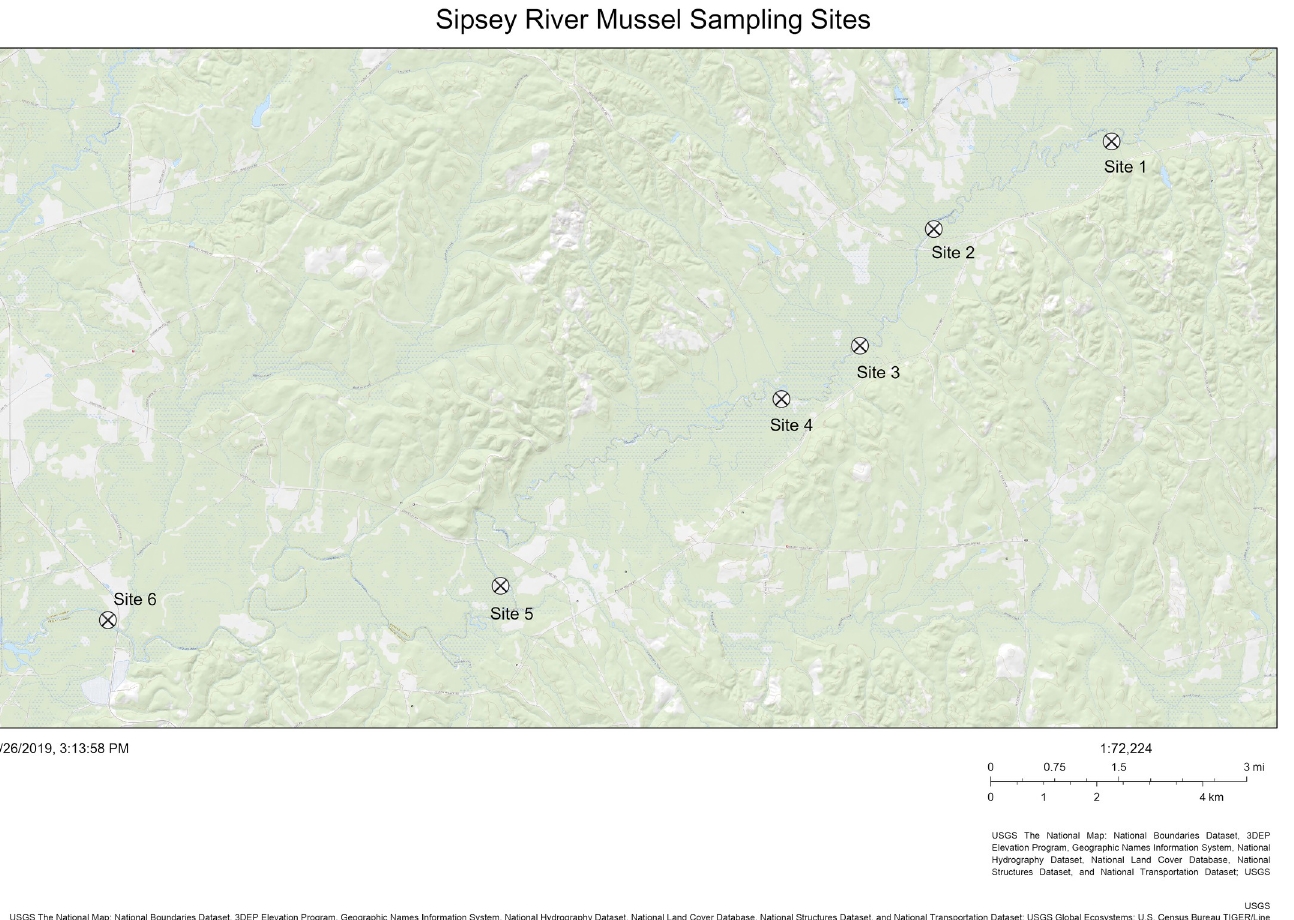
Fig 1. Five individuals each of four mussel species and three samples of seston were collected between July 28 and September 16, 2016 from each site shown along a ~50 km stretch of the Sipsey River, Alabama, USA. Temperature, pH, specific conductance ( μ S/cm), conductivity ( μ S/cm), dissolved oxygen (mg/L), and ammonia, orthophosphate, nitrate, and nitrite from both the water column and the sediment ( μ g/L) were collected at three times from each site between June 9 and September 28, 2016. The river flow is from northeast to